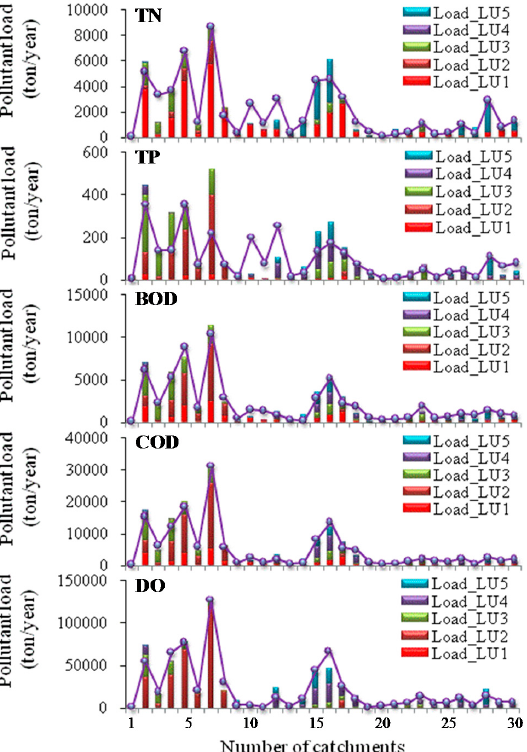
Figure 5. Water pollution loads from different land covers in 30 Japanese catchments (1996). The lines represent the observed water pollution loads; the colored bars represent the water pollution loads associated with the different land covers.